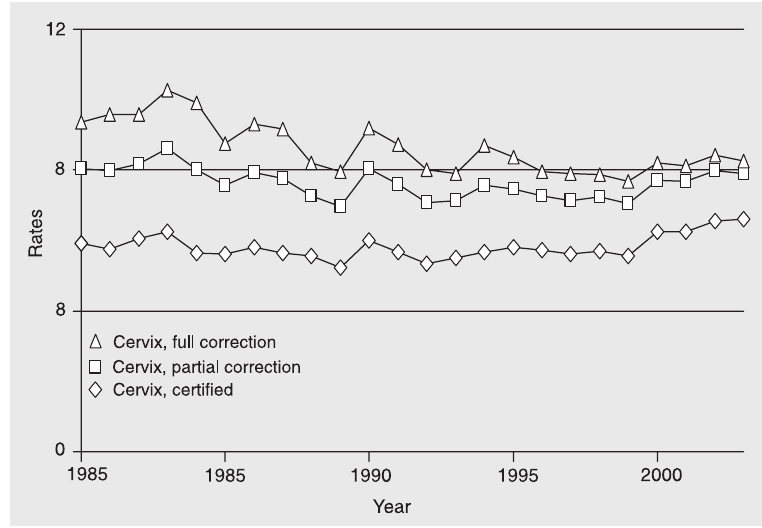
Figure 2. Cervical cancer mortality rates in São Paulo, Brazil, 1980-2003, corrected or not for NOS (not otherwise specified). Data are reported as frequency per 100,000 women with NOS on death certificate (certified), partially corrected to eliminate NOS (partial) of fully